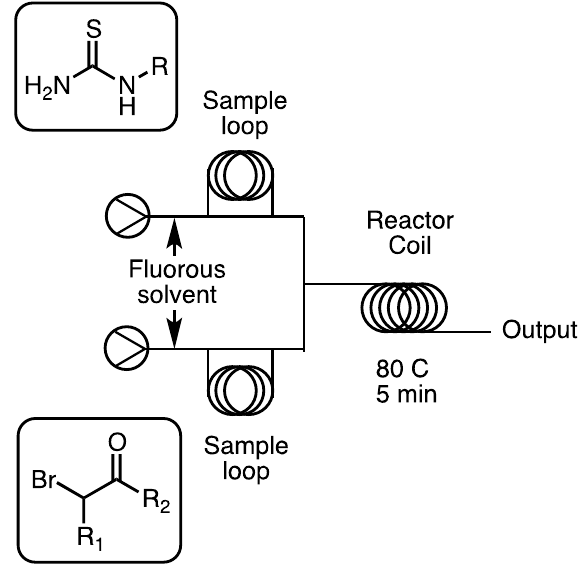
Figure 1. Diagram of the flow reactor set up for library